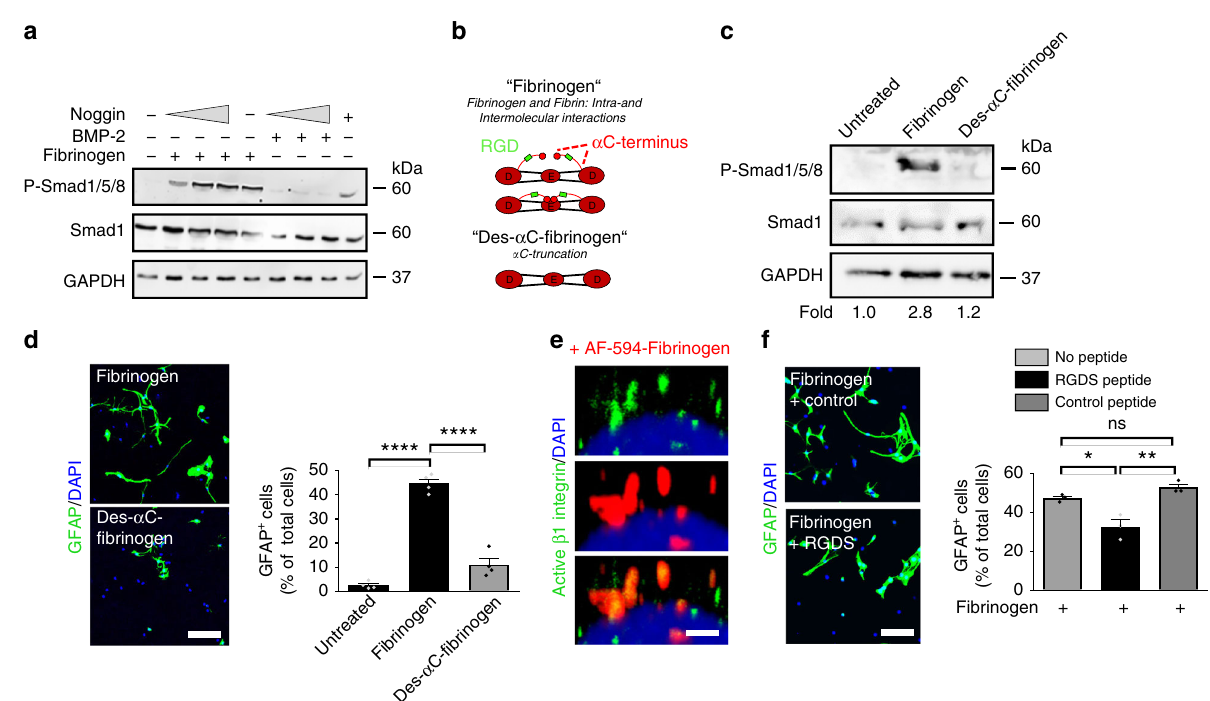
Fig. 4 Fibrinogen α C domain requirement for NSPC differentiation into astrocytes. a Immunoblot for P-Smad1/5/8 and Smad1 in NSPCs pretreated with an increasing concentration of Noggin before fi brinogen stimulation. BMP-2 served as positive control. b Scheme illustrating fi brinogen fractions isolated from plasma. Human Des- α C- fi brinogen lacks most of the residues of the C-terminus of the A α chain including the RGD sequence. c Immunoblot for P- Smad1/5/8 and total Smad1 protein expression in NSPCs 2 days after fi brinogen or Des- α C- fi brinogen treatment. Values are mean of n = 3 independent experiments. d GFAP + astrocytes in fi brinogen- and Des- α C- fi brinogen-treated NSPC cultures 2 days after initiation of differentiation. Scale bar, 125 μ m. Quanti fi cation of GFAP + astrocytes derived from fi brinogen- or Des- α C- fi brinogen-treated NSPCs. Results are from four independent experiments (mean ± s.e.m, one-way ANOVA and Bonferroni ’ s multiple comparisons test, **** P < 0.0001). e Active β 1-integrin (green) immunostaining in WT NSPCs treated for 15 min with AF594- fi brinogen (red). Scale bar, 2 μ m. Representative images of two independent experiments are shown. f GFAP + astrocytes in untreated and fi brinogen-treated NSPC cultures pretreated with the integrin-blocking RGDS or the control PDEA peptides for 2 days. Scale bar, 60 μ m. Quanti fi cation of GFAP + astrocytes derived from untreated and fi brinogen-treated NSPCs pretreated with the PDEA (control) and RGDS peptides. Results from three independent experiments performed in duplicates are shown (mean ± s.e.m, one-way ANOVA and Bonferroni ’ s multiple comparisons test, * P < 0.05, ** P < 0.01, ns not signi fi